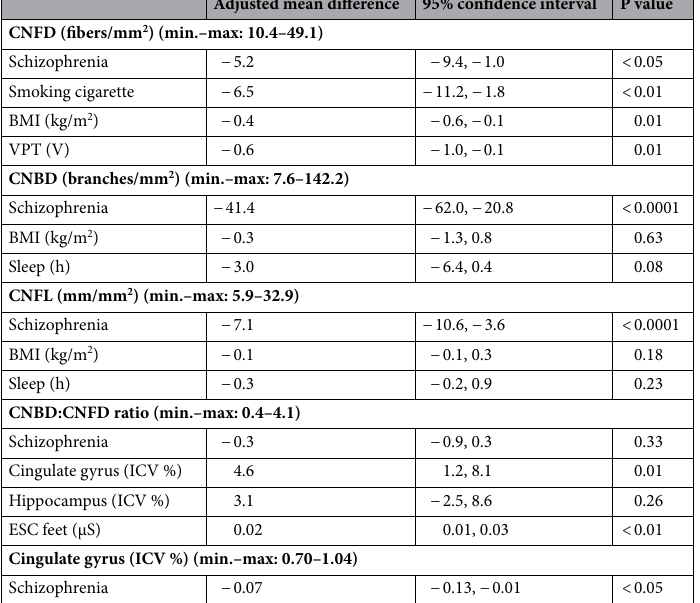
Table 2. The association of cognitive function, corneal nerve fiber measures, cingulate gyrus volume with schizophrenia after adjustment for cofounders. All the variables considered in the fitted model had P < 0.05. The cingulate gyrus volume includes Rostral Anterior Cingulate Gyrus and Caudal Anterior Cingulate Gyrus. CNFD corneal nerve fiber density, CNFL length, CNBD branch density, VPT vibration perception threshold, ESC electrochemical skin conductance, ICV intra cranial